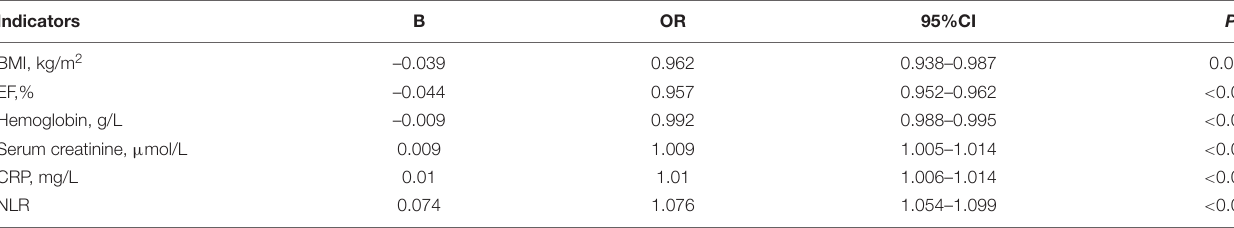
TABLE 3 | Multivariate logistic association for severe stage among the whole population.